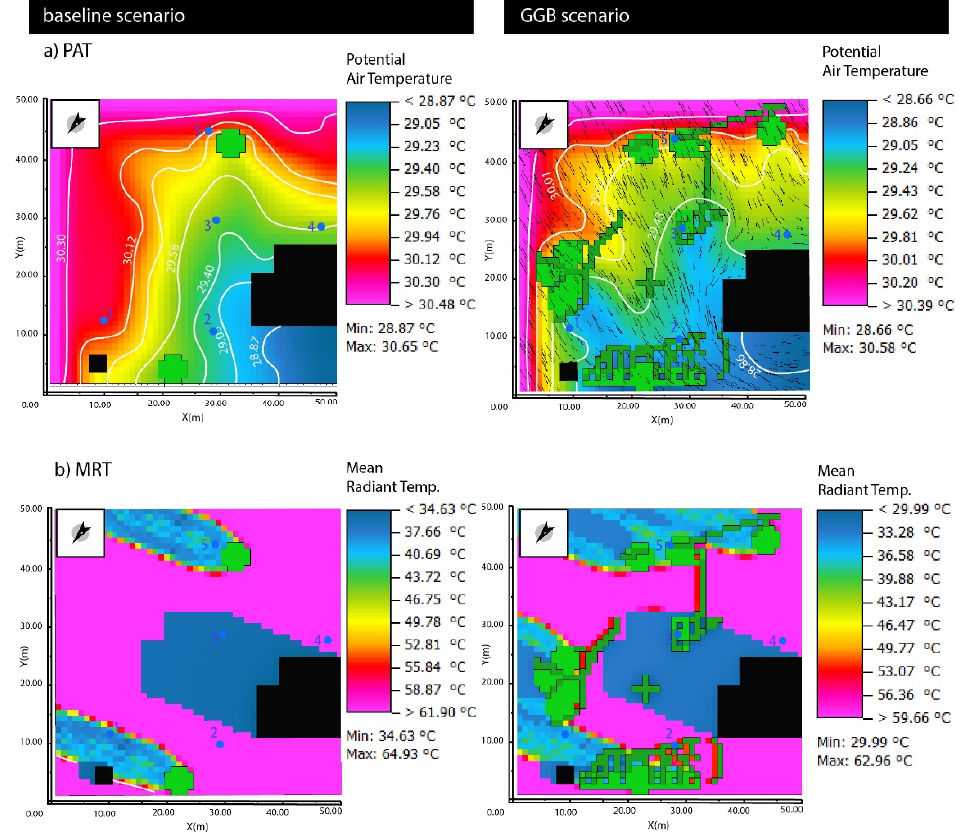
Figure 4. Spatial distribution of ( a ) PAT and ( b ) MRT in baseline scenario ( left ) and GGB scenario ( right ).